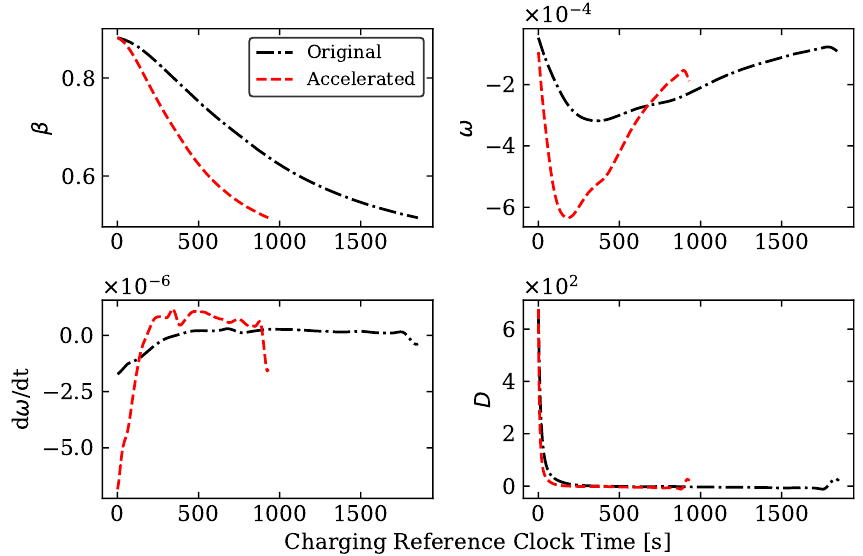
Figure 8. Scaling comparison of discharging mode at the centerline, phase 2.